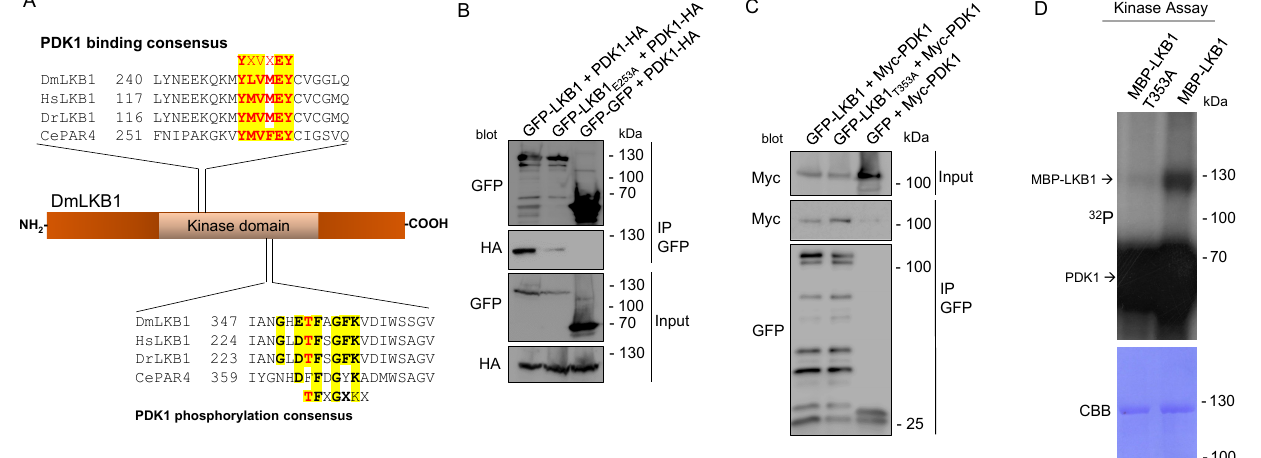
Figure 1. LKB1 displays conserved PDK1-binding and -phosphorylation motifs and is phosphory- lated by PDK1 in vitro. ( A ) Scheme of Drosophila LKB1 and sequence alignment of PDK1-binding and consensus-motif. DmLKB1— Drosophila melanogaster LKB1, HsLKB1— Homo sapiens LKB1, DrLKb1— Danio rerio LKB1 (zebrafish), CeLKB1— C. elegans LKB1. ( B , C ) S2R+ cells were co-transfected with HA-PDK1 and either wild type GFP-LKB1 and GFP-LKB1 E253A ( B ) or wild type GFP-LKB1 and GFP-LKB1 T253A ( C ) and GFP alone. GFP-proteins were immunoprecipitated and GFP(-LKB1) and HA-PDK1 ( B ) or Myc-PDK1 ( C ) were detected by immunoblotting. ( D ) Recombinant wild type or mutant MBP-LKB1 produced in E. coli was used in a 32P radioactive kinase assay with recombinant PDK1. CCB is colloidal coomassie blue, which was used to visualize the LKB1 input